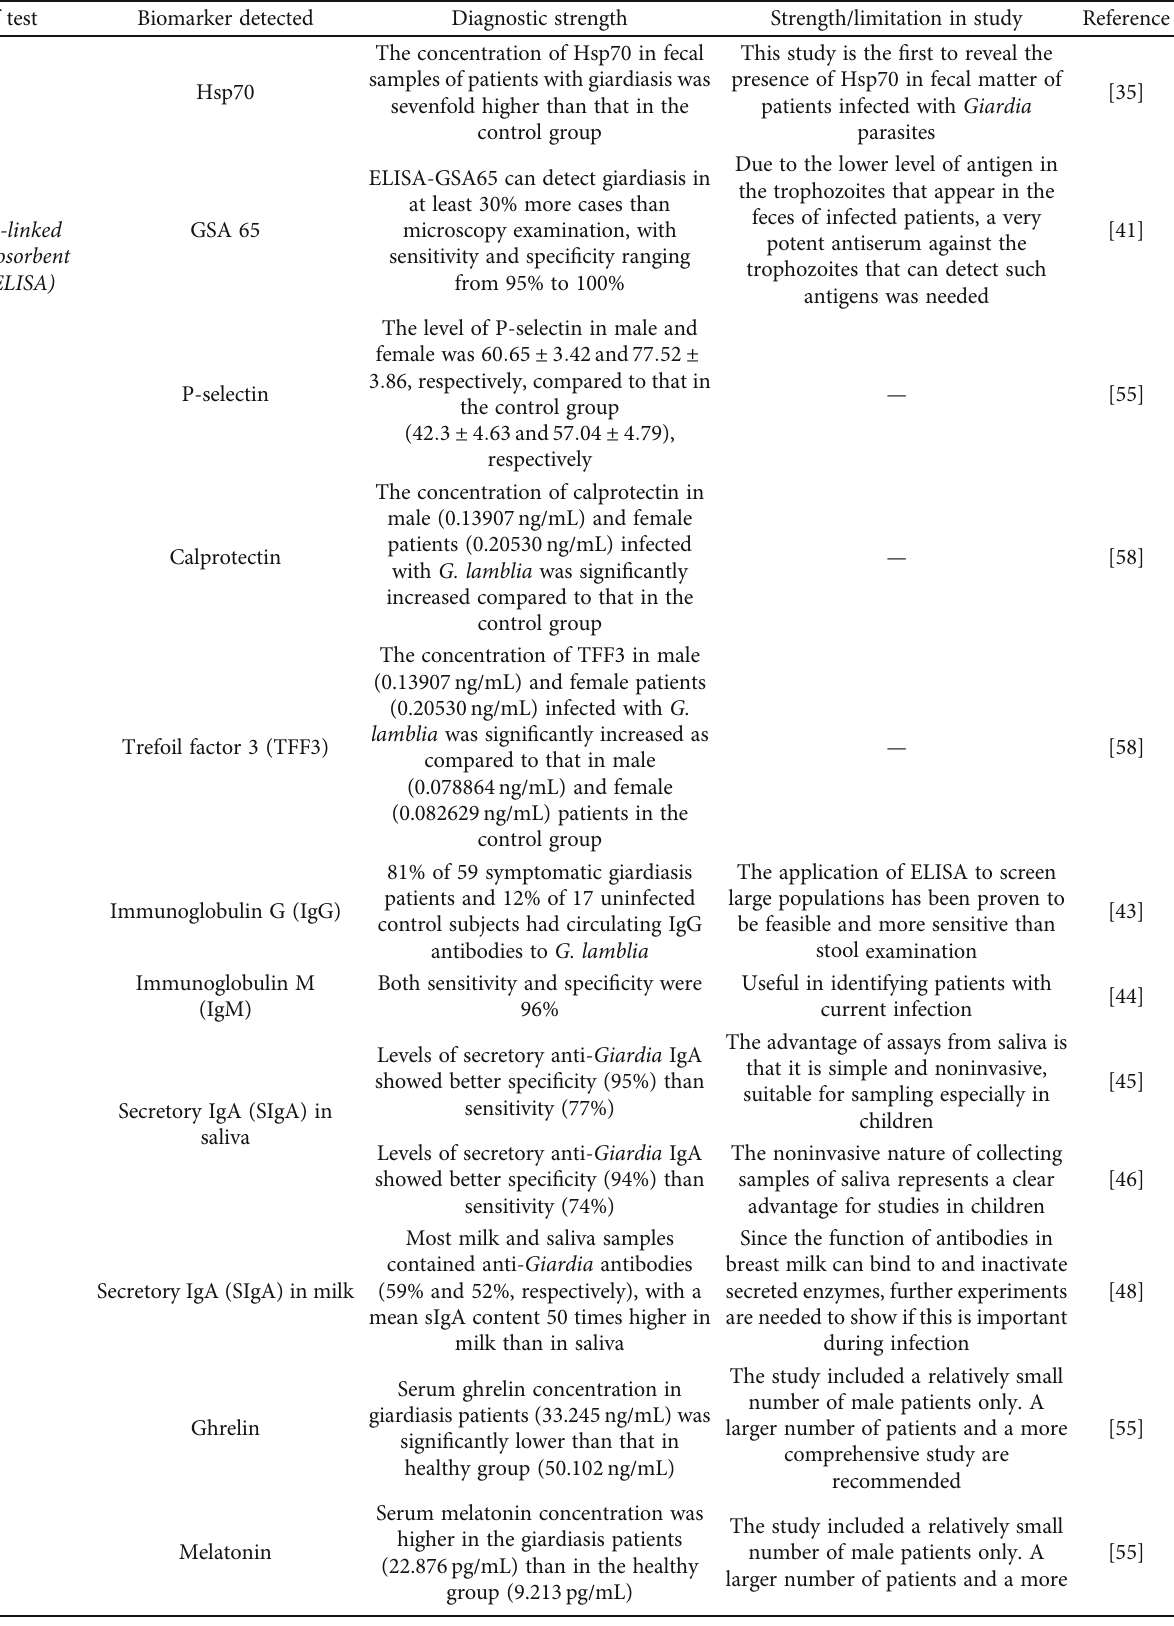
Table 2: Diagnostic strength of the identi fi ed